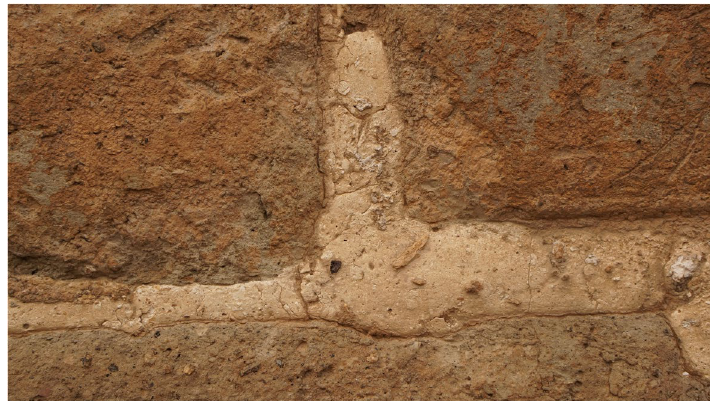
Fig. 11 No other aggregates are visible in dense original joints built in Xinguangwu, Shanxi Province, circa 1374-1575. The largest joint width is approximately 1.5 cm (Source: Tongji-ACL)